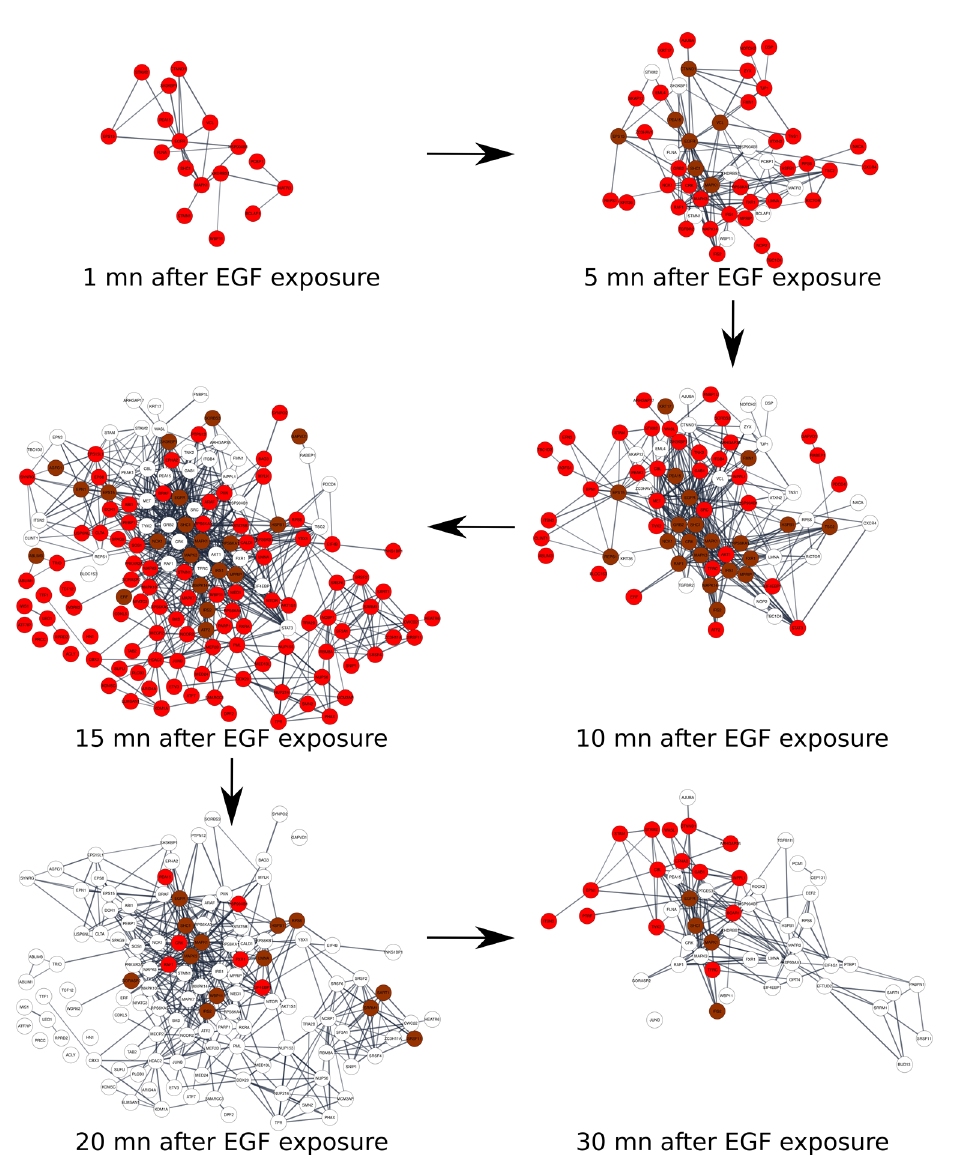
Figure 11. An interaction graph between the proteins included in the most striking module identified by AMINE for each of the time points after EGF exposure. The proteins in red and those in brown are those that were differentially phosphorylated compared to the control. The proteins in red represent those that were differentially phosphorylated at this time point compared to the previous time point (newly phosphorylated proteins). The proteins in brown are those that were differentially phosphorylated but were already differentially phosphorylated at the previous time point. Finally, the proteins with a white background are those that were no longer differentially phosphorylated at this time point but were at the previous time point (or back to normal).